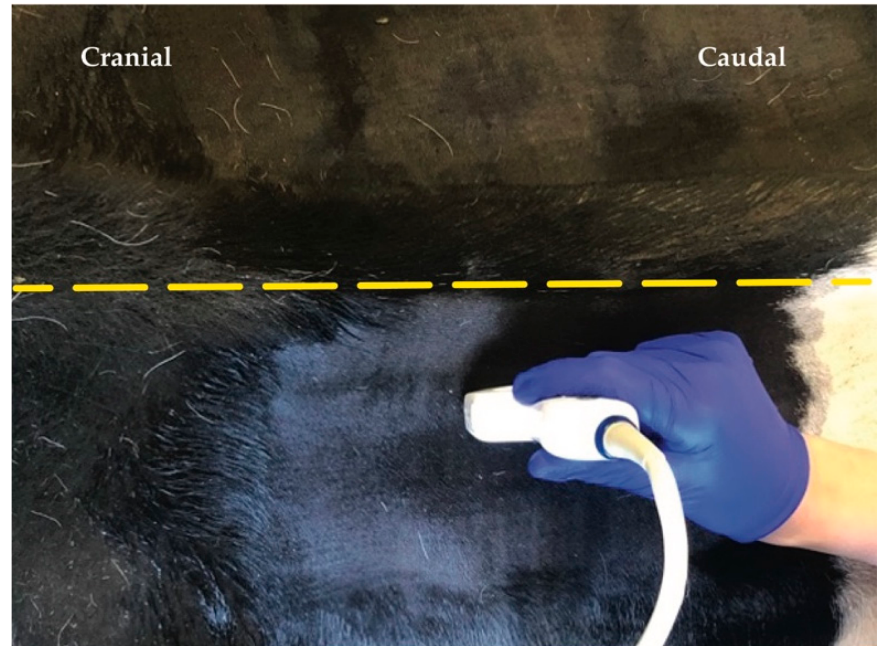
Figure 3. Position of the ultrasound probe parasagittally from dorsal midline (yellow dashed line).